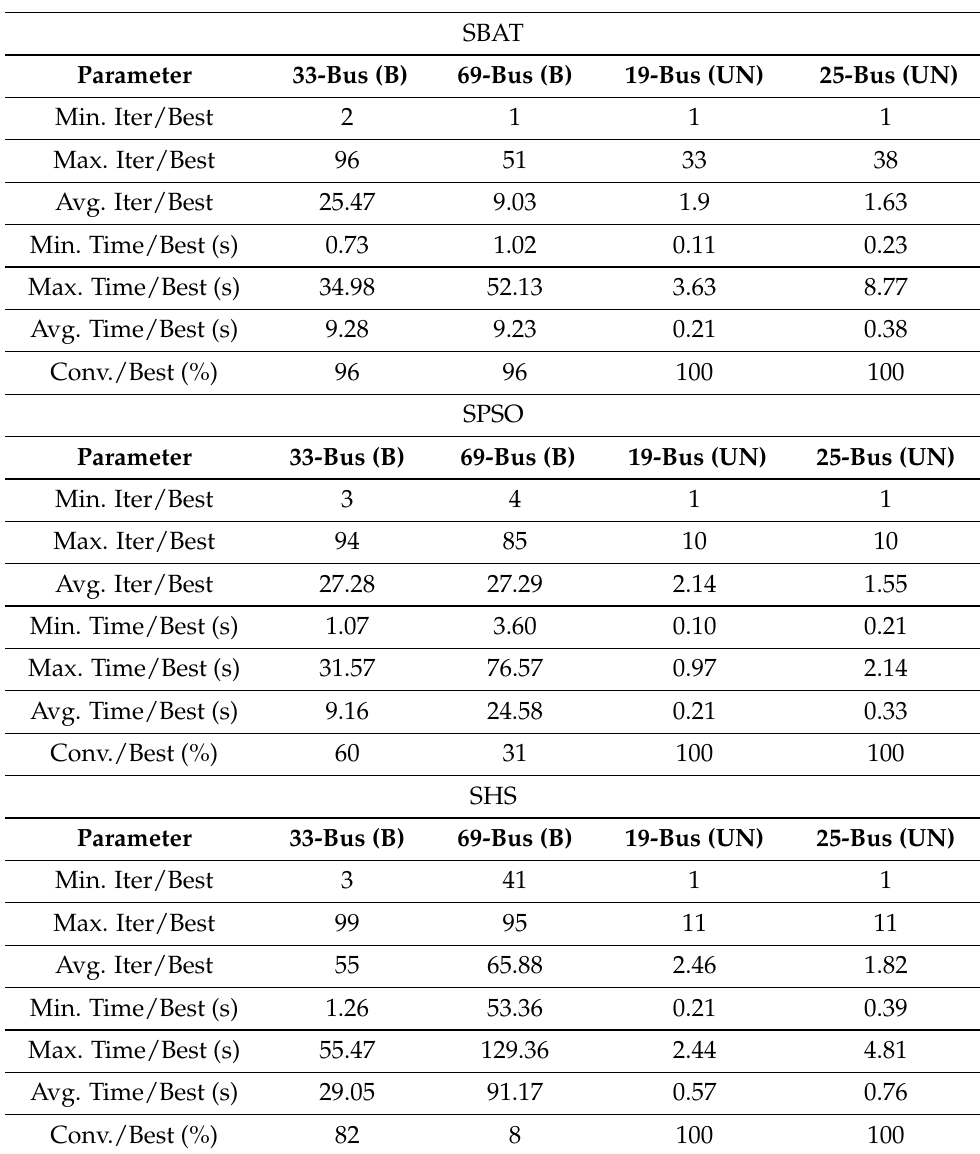
Table 17. Convergence analysis SBAT/SPSO/SHS—fixed demand.